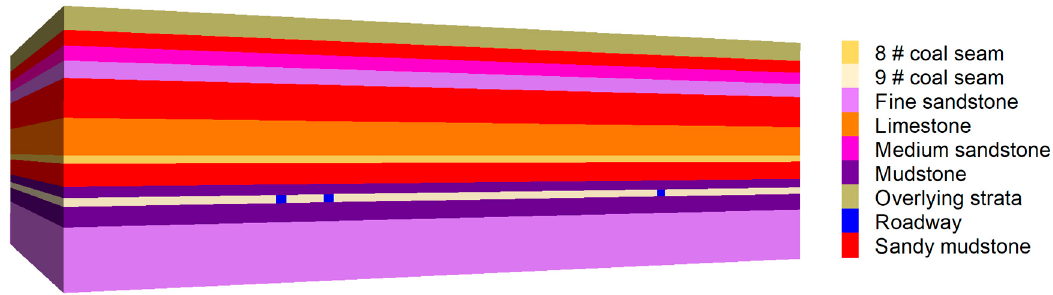
Figure 6. Three-dimensional numerical calculation model.